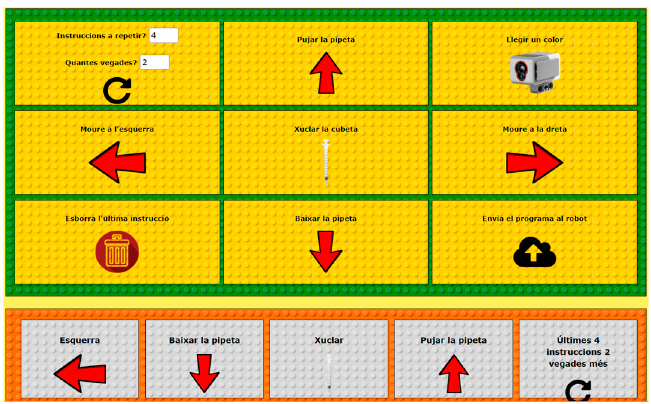
Figure 3. Program tab in the Control Panel where the robots are programmed [27].